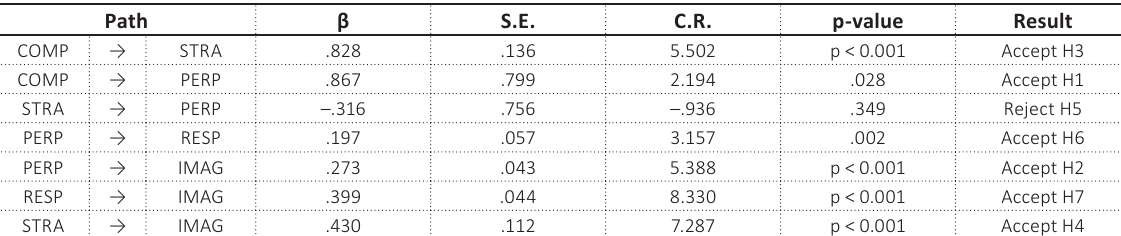
Table 5. Hypotheses